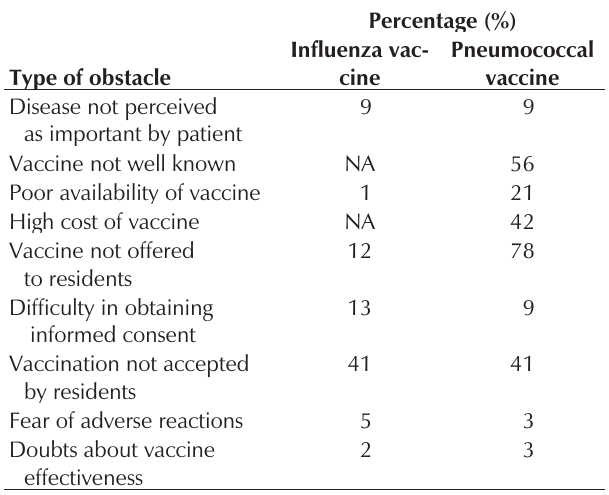
Various obstacles to the immunization perceived as impor- tant or very important by physicians